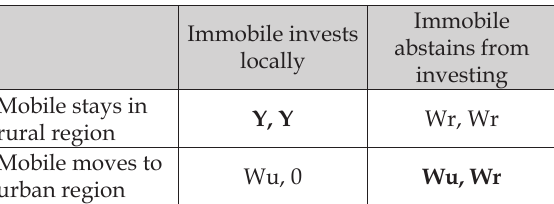
Table 1. The rural coordination